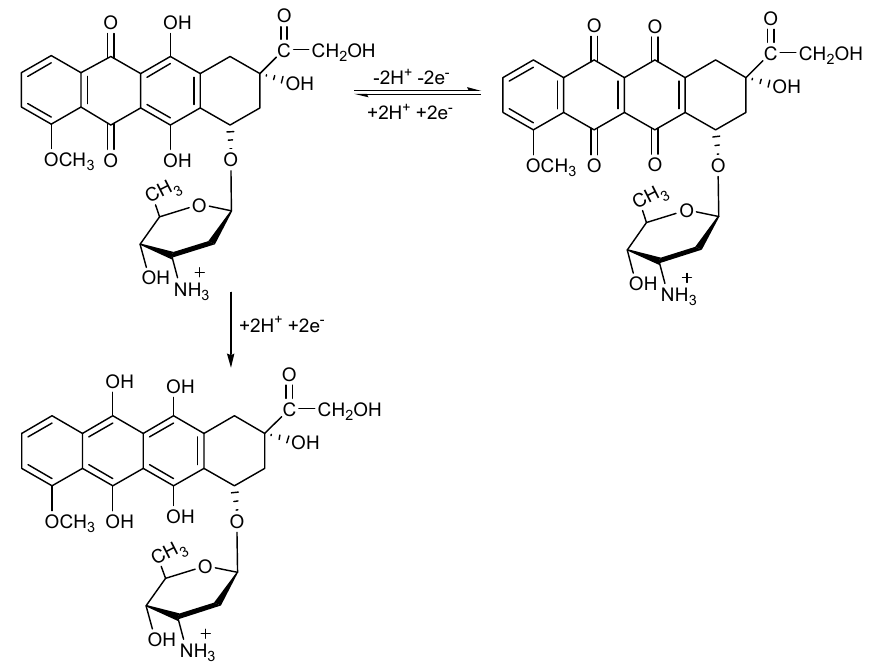
Figure 8. Proposed overall mechanism for the electrochemical oxidation/ reduction of doxorubicin.